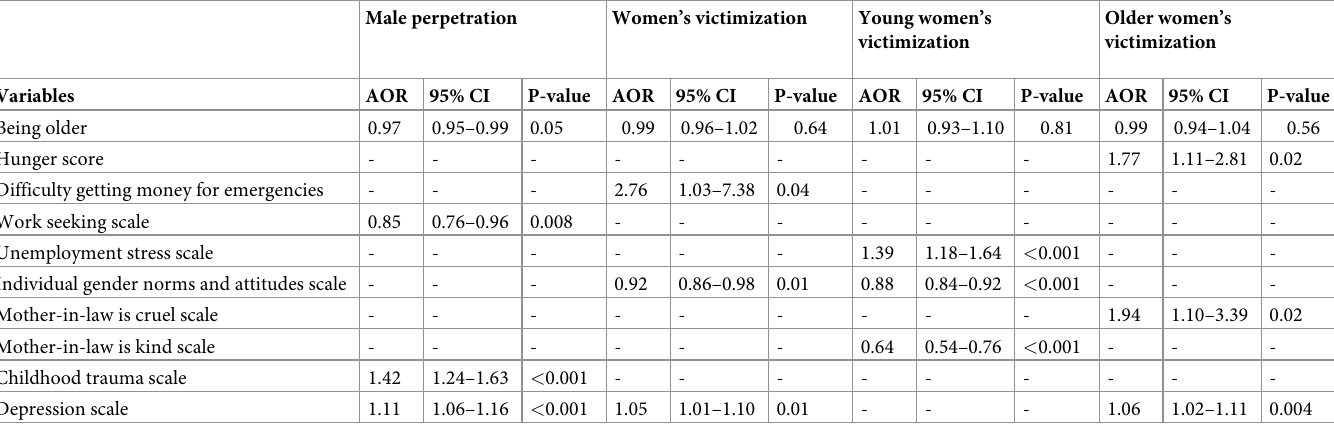
Table 3. Multivariate associations of IPV perpetration by men and victimisation of women in the past year with comparison among women by in-law